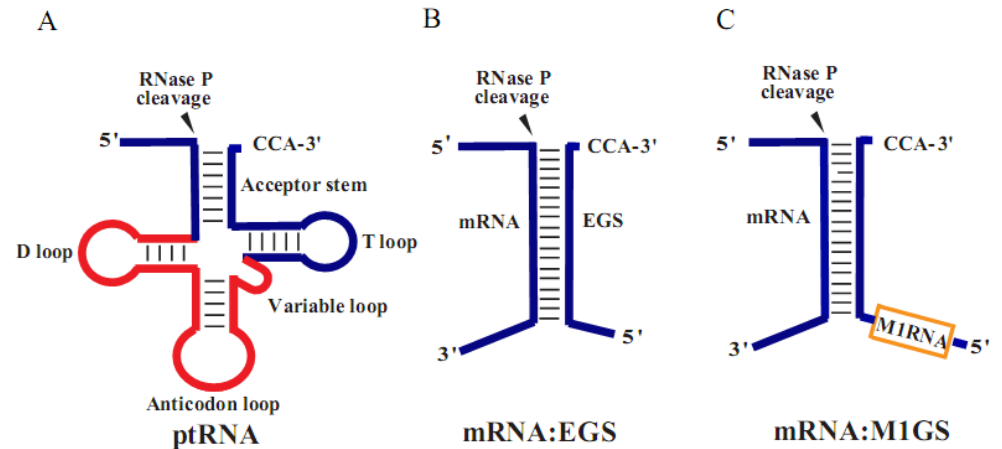
Figure 1. Substrates for RNase P and M1 ribozyme. ( A ) pre-tRNA (ptRNA); ( B ) complex of EGS and target mRNA; ( C ) M1GS RNA binding to its mRNA substrate. Arrowhead indicates the cleavage sites.